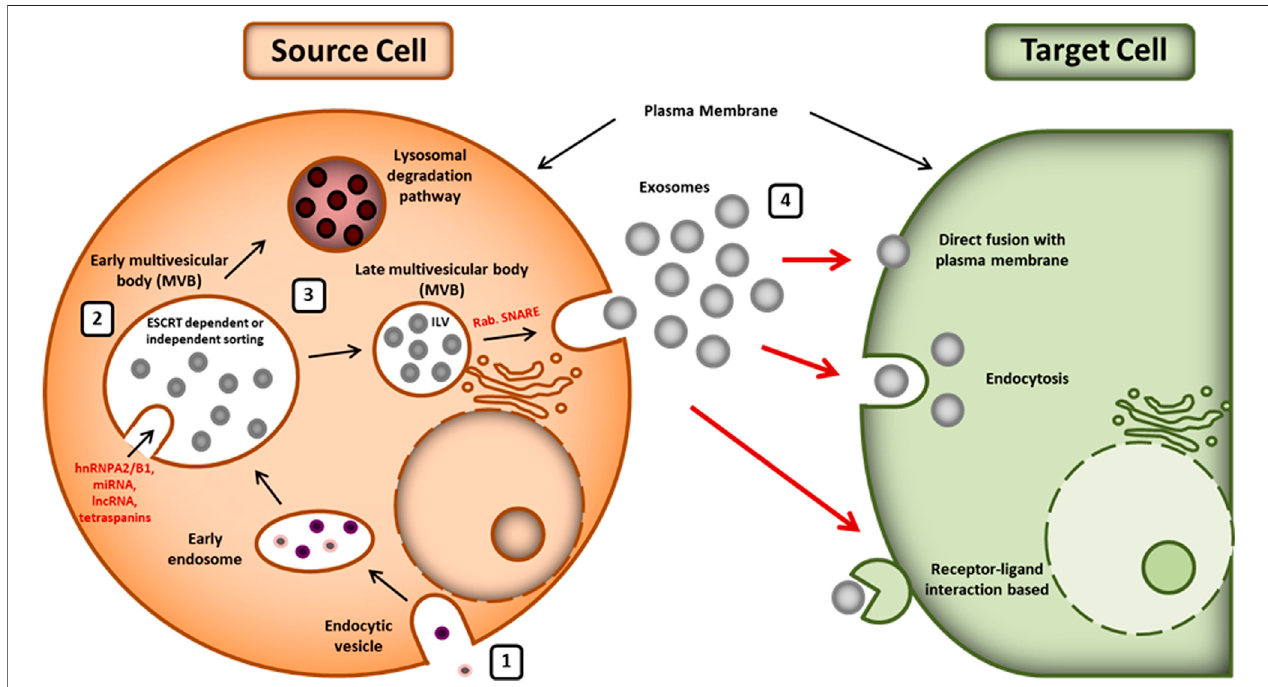
FIGURE 1 | Biogenesis, release, and uptake of exosomes: (1) exosome biogenesis starts with the formation of an endosomal vesicle from the plasma membrane. The endocytic vesicle generates ILV, which further forms the MVB. (2) Sorting of exosomal content is mediated by various ESCRT-dependent and independent mechanisms.Exosomalcargoes(hnRNPA2/B1, lncRNAs,miRNA,tetraspanins, etc.)approachtheMVBmembrane inordertobeloadedintoexosomes. (3) TheMVBs can either release exosomes outside the cell using Rab and SNARE complex or be degraded by lysosomes. (4) The released exosomes can be taken by the recipientcellswhetherbydirectfusiontoplasmamembrane,byendocytosis,orbyligand-receptorinteraction.hnRNPA2/B1:heterogeneousnuclearribonucleoproteins A2/B1; lncRNA: long noncoding RNA, miRNA: microRNA, ESCRT: endosomal-sorting complex required for transport; MVB: multivesicular body; ILV: intraluminal vesicle; SNARE: soluble N-ethylmaleimide-sensitive fusion attachment protein